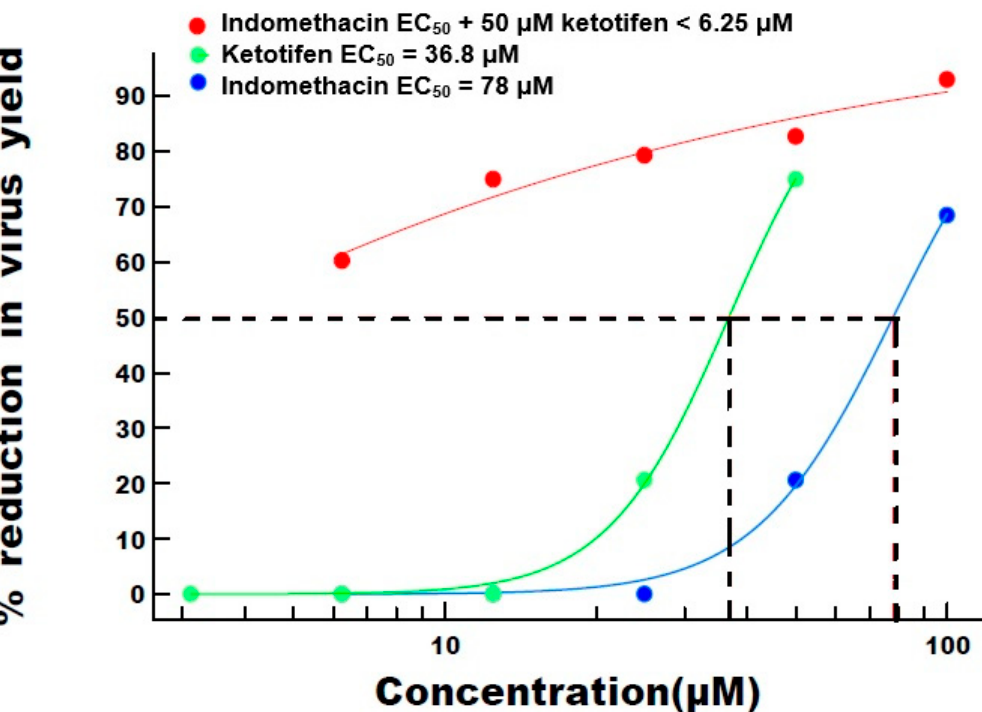
Figure 3. Dose–response curves for indomethacin and ketotifen, alone and in combination.